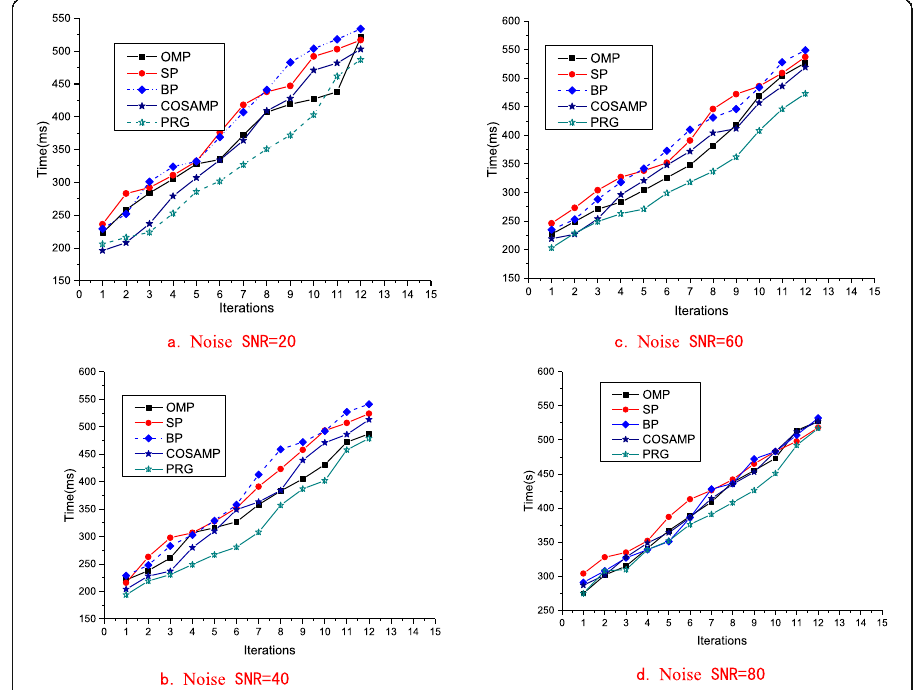
Fig. 9 Reconstruction time of heat source signals under sinusoidal signal plus narrowband Gaussian